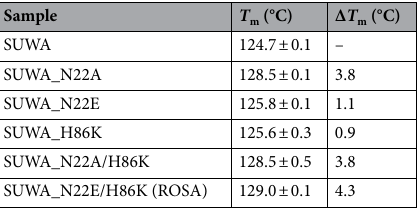
Table 2. Denaturation midpoint temperatures ( T m ) of the SUWA mutants.